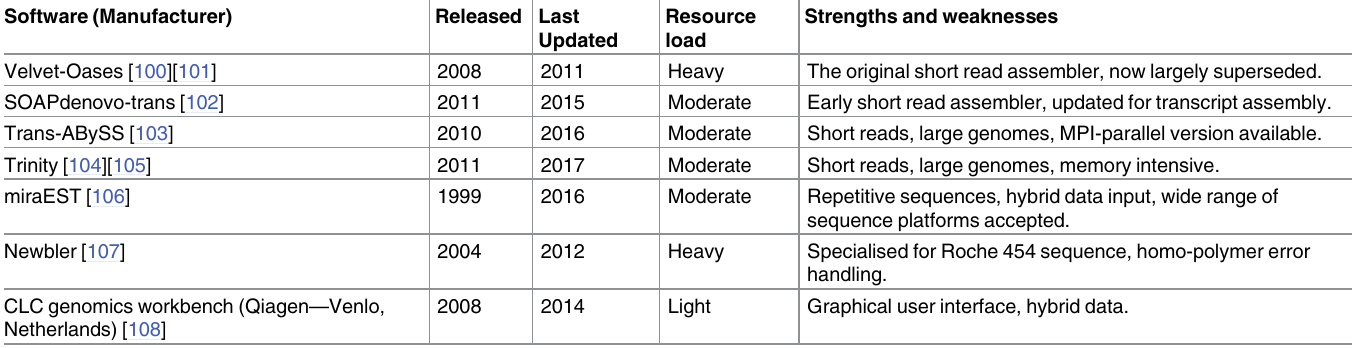
Table 3. RNA-Seq de novo assembly